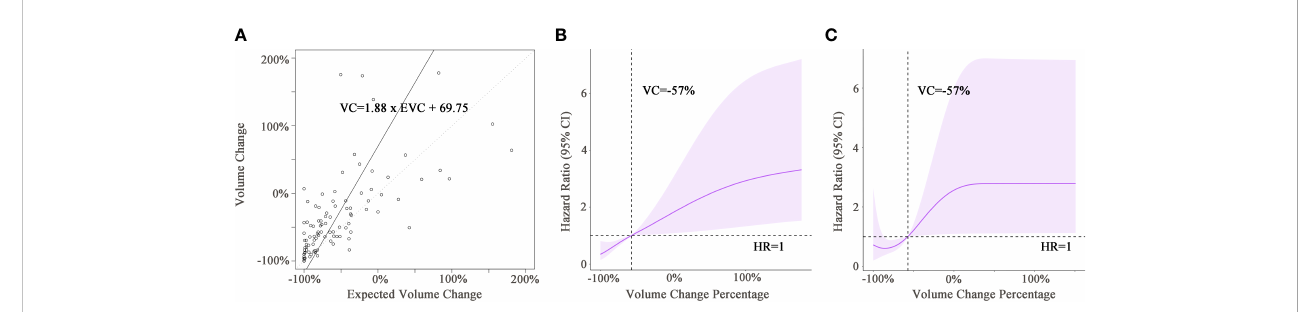
FIGURE 3 (A) The scatter plot shows the correlation between the expected viable volume change and actual viable volume change. The full line was fi tted by linear regression models, with the equation presented in the rectangular frame. The dotted line is the line of reference for VC = EVC. (B, C) Graphs of restricted cubic spline with 95% con fi dence intervals for volume change and hazard ratio of death in the training cohort (B) and validation cohort (C) . Black dotted lines indicate that the hazard ratio of death equaled 1 when the volume change was − 57% in both cohorts. VC, viable tumor volume change; EVC, expected viable tumor volume change; HR, hazard